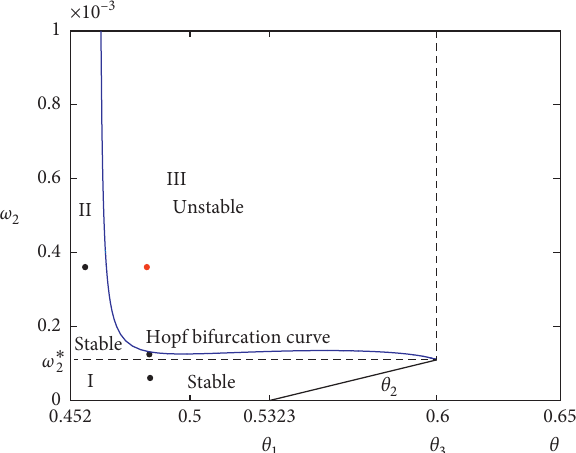
Figure 2: Stability region of P ∗ and Hopf bifurcation curve in θ − ω